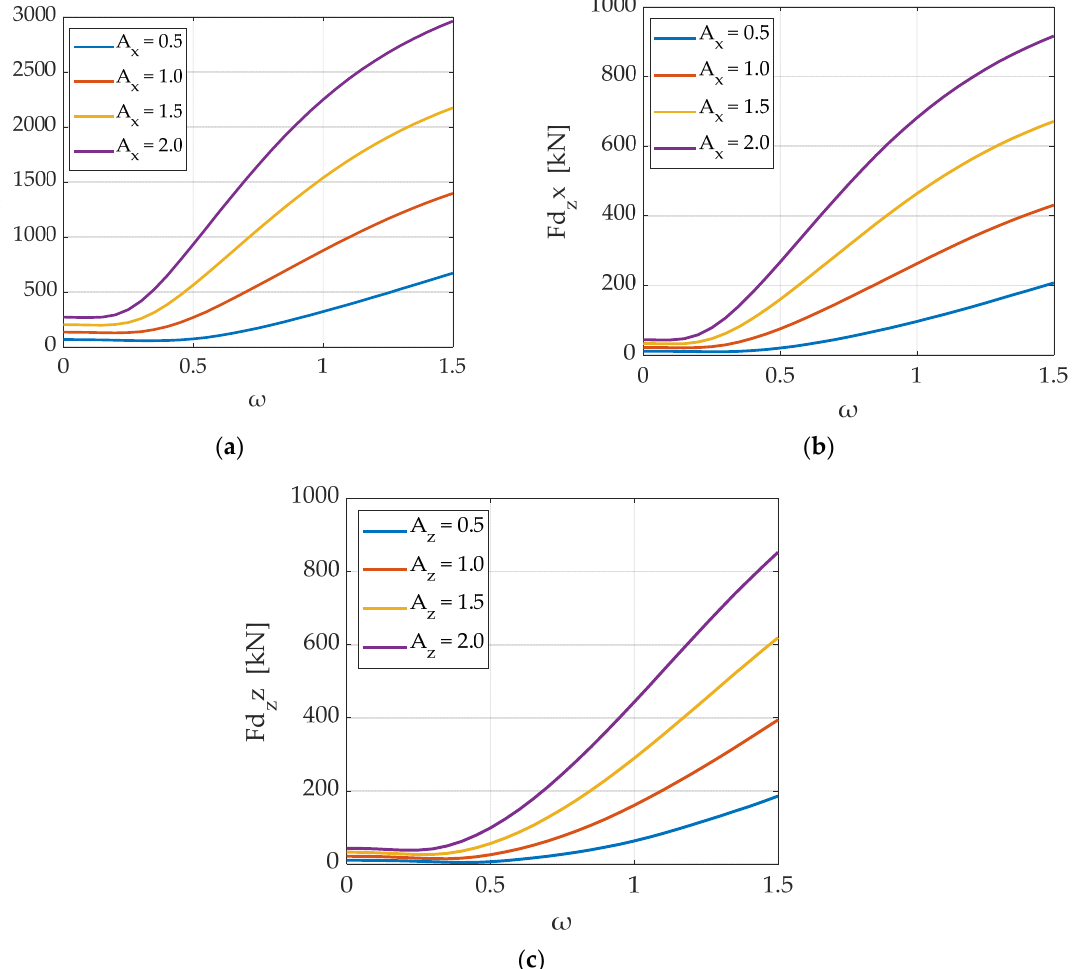
Figure 9. Horizontal and vertical dynamic tensions at the top of the mooring line against wave frequency ω for various values of horizontal motion amplitudes A j = 0.5, 1.0, 1.5, and 2.0 m: ( a ) Fd x x; ( b ) Fd z x; ( c ) Fd z